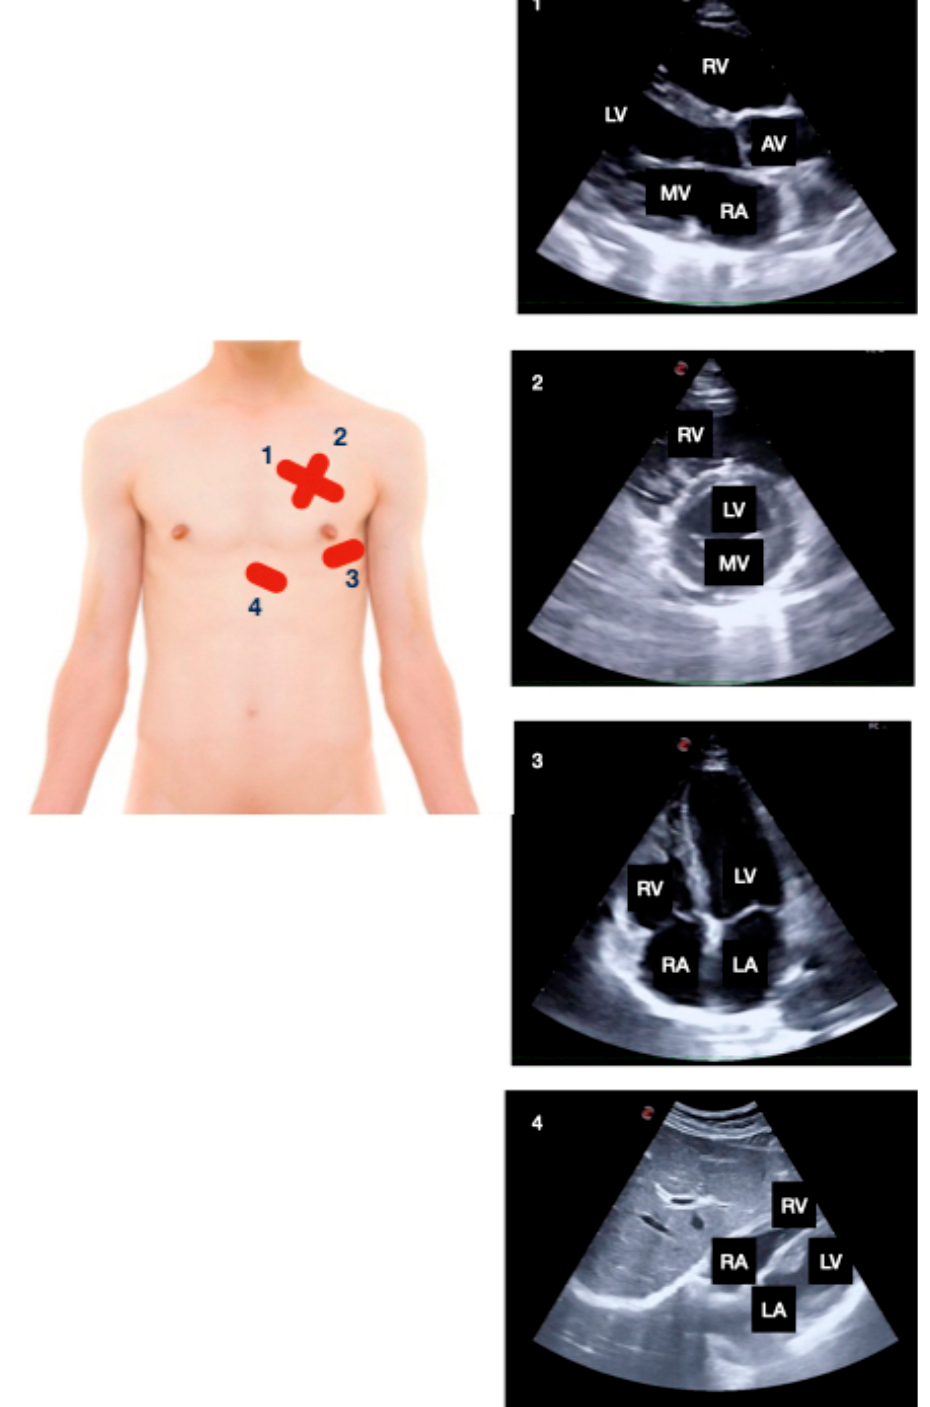
Figure 1. Focused cardiac ultrasound: (1) parasternal long and (2) short axis, (3) apical four chambers and (4) subxiphoid. AV: aortic valve, LA: left atrium, LV: left ventricle, MV: mitral valve, RA: right atrium, RV: right ventricle.